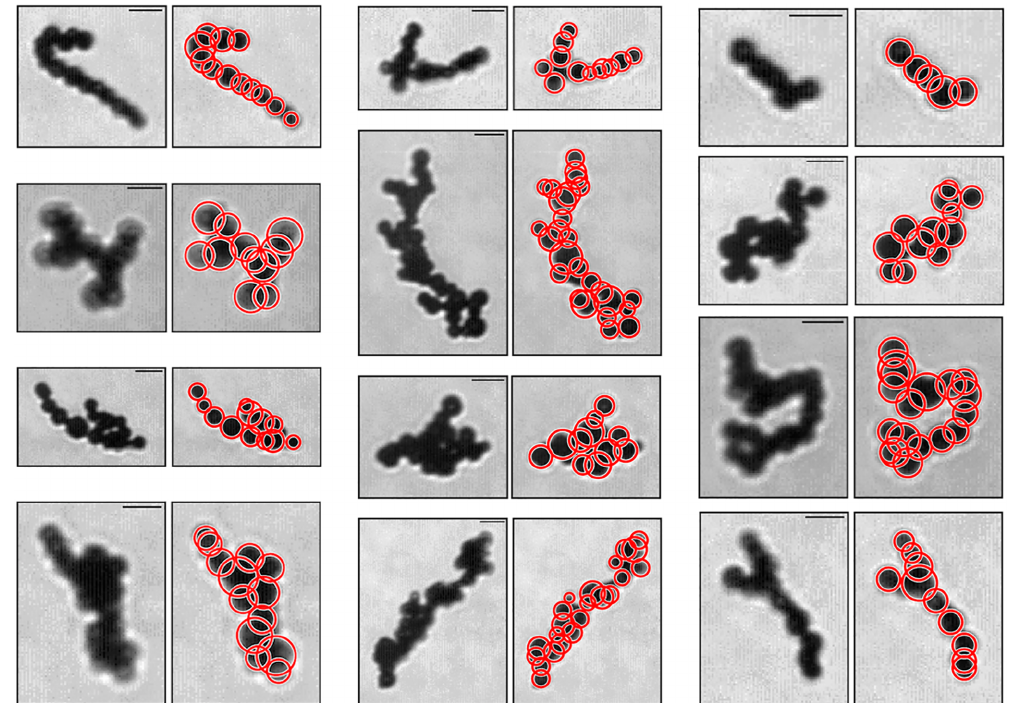
Figure 4. CPI images of frozen droplet aggregates (FDAs, left image of each column) and those with determined element frozen droplets (red circle, right image of each column). The 46µm scale bar is shown in each FDA image.